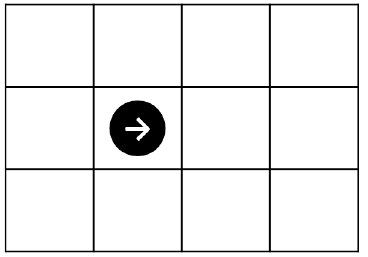
Figure 2. View of an agent when facing